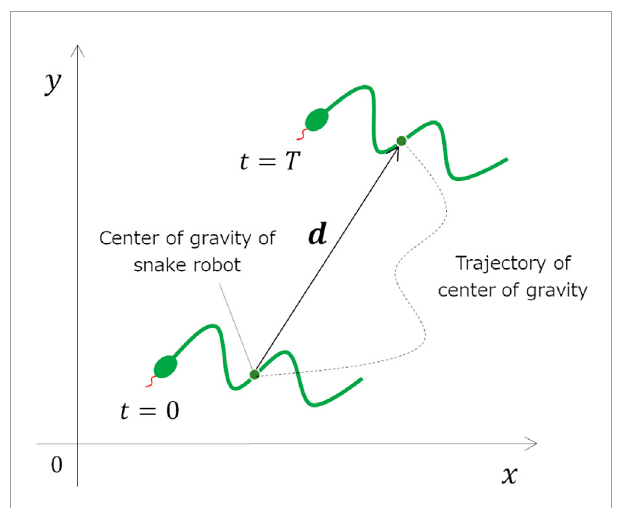
FIGURE 9 Definition of variables related to the snake robot’s